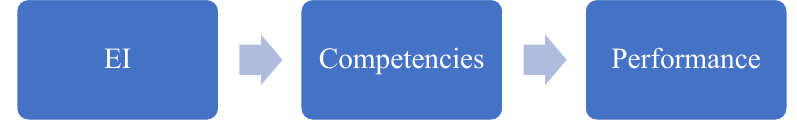
Figure 1. The Proposed Model. Source: The authors.